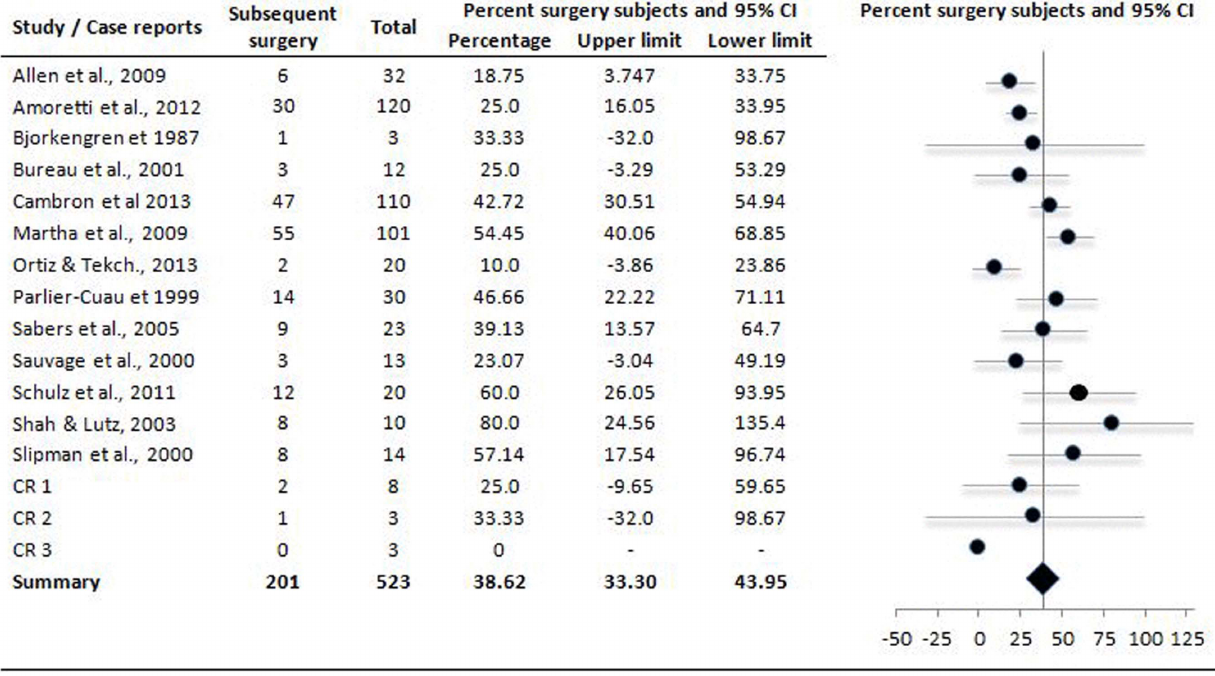
Figure 4. Forest plot showing effect sizes of subjects underwent surgical treatments subsequent to failure of percutaneous treatments of the LFJCs in individual studies (closed circles) and the overall effect size achieved in meta-analysis (diamond). CR 1/CR 2/CR 3 as given in Figure 2. doi:10.1371/journal.pone.0111695.g004 PLOS ONE |